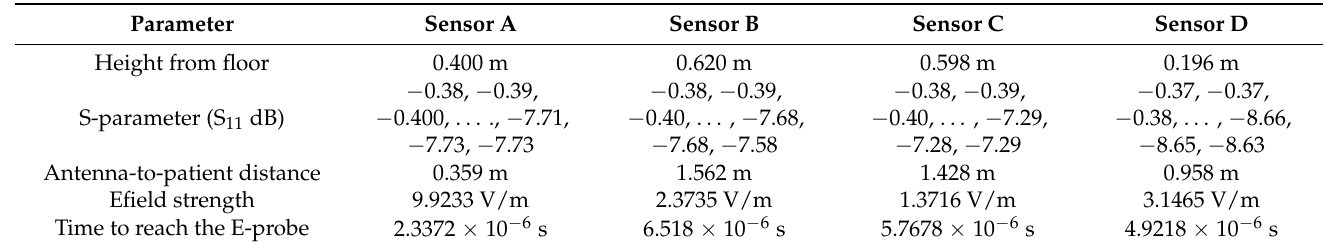
Table 2. DT-model data